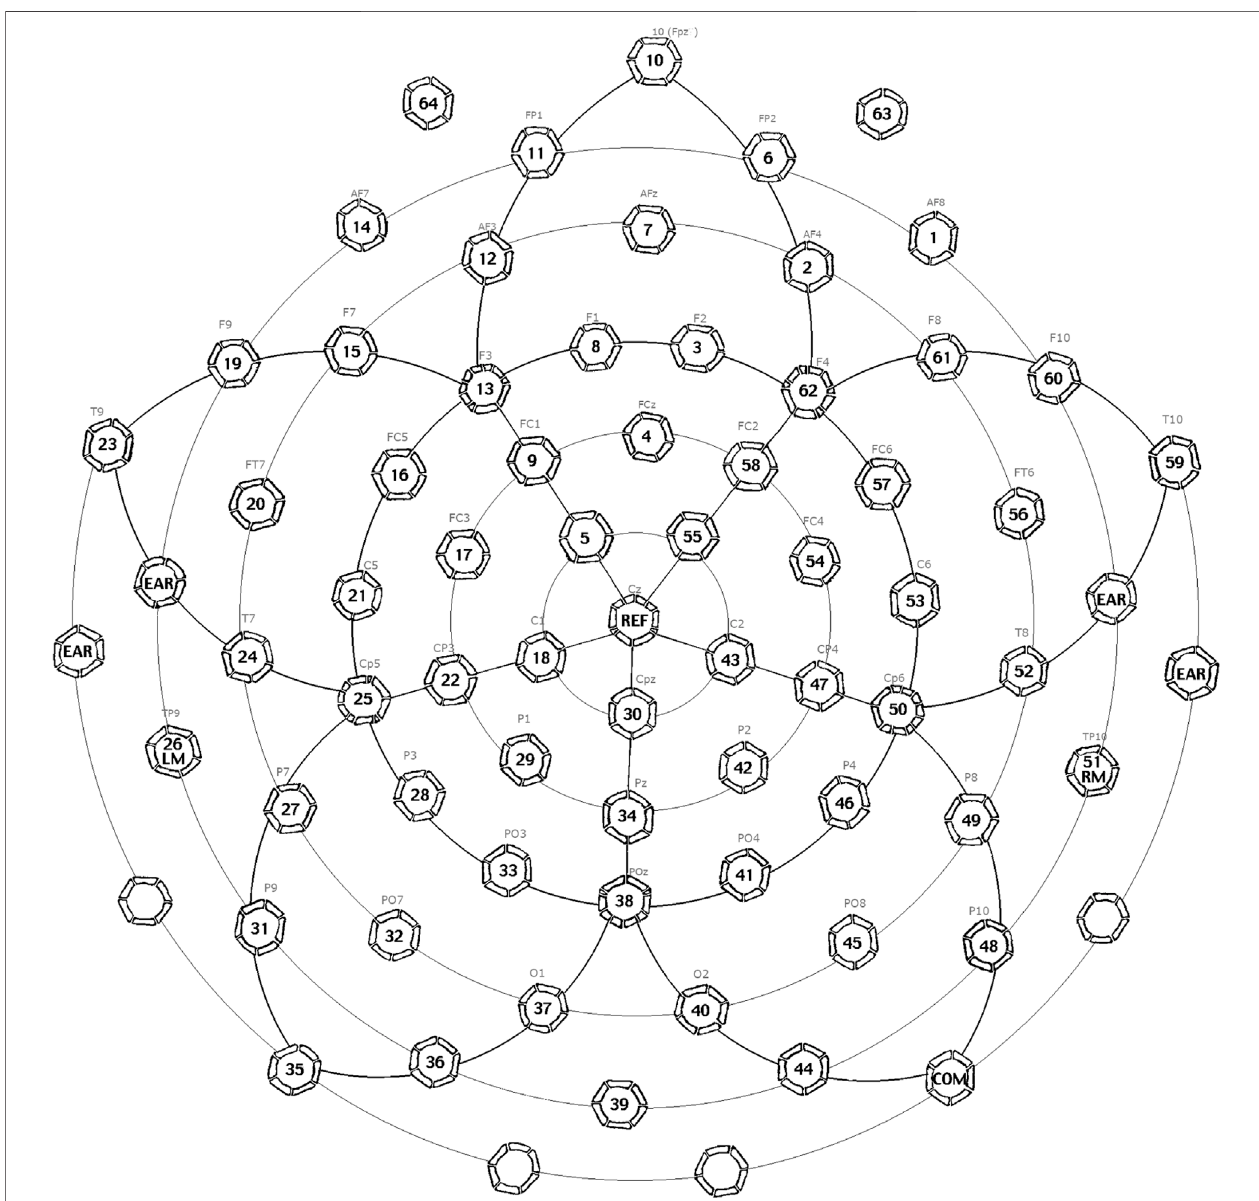
FIGURE A1 | EGI GSN 64 v.2 montage with closest labels in the 10-10 labels.